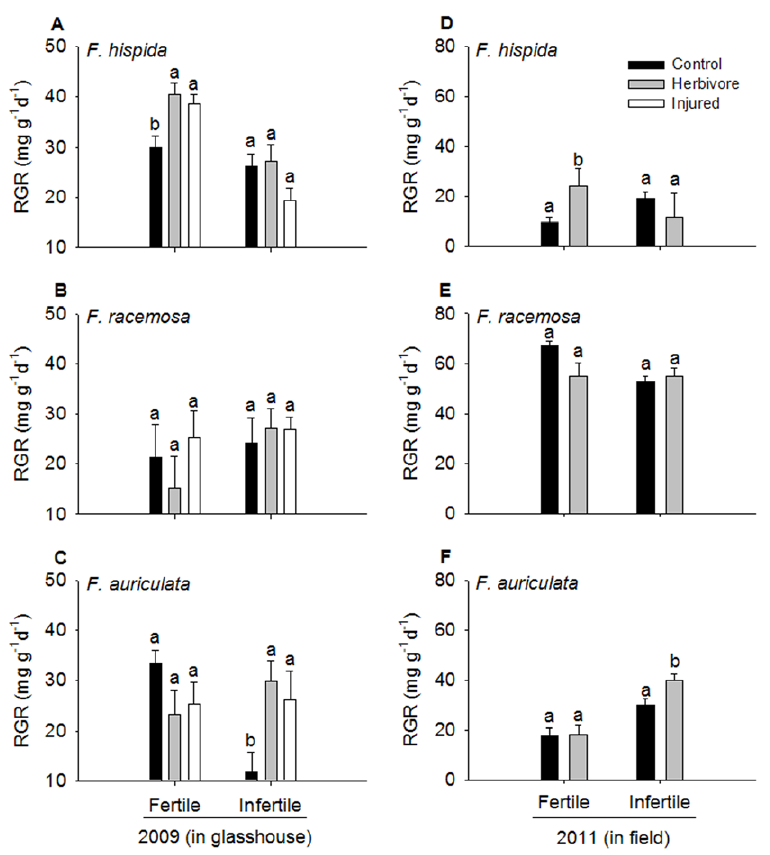
Figure 1. Effect of treatments on RGR of Ficus saplings under two soil nutrient levels. Significant differences between treatments are marked with different letters (mean 6 SE, n=5 in 2009, n=12 in 2011, P , 0.05). RGR, relative growth rate (mg ? g 2 1 ? d 2 1